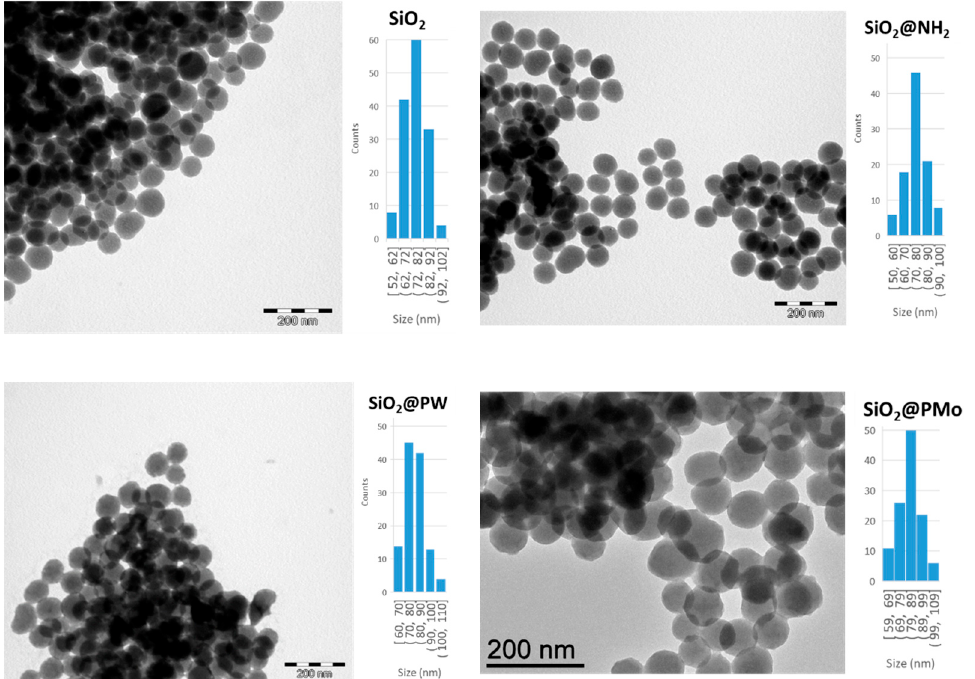
Figure 2. TEM images and diameters distribution of SiO 2 , SiO 2 @NH 2 , SiO 2 @PW and SiO 2 @PMo beads.